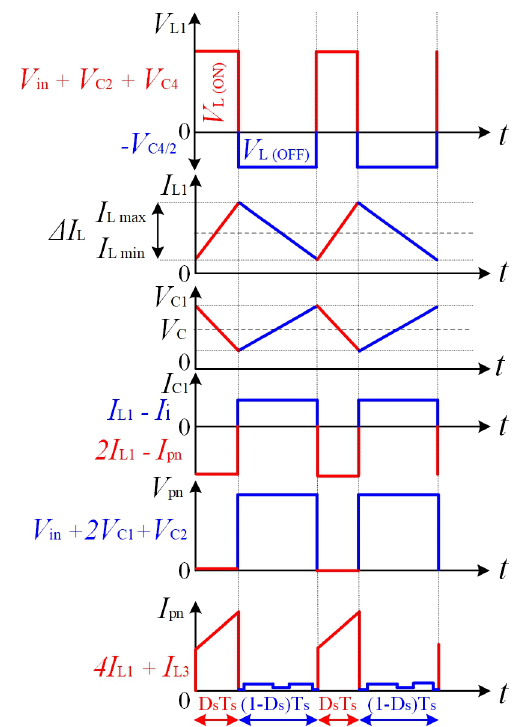
Figure 3. Key switching waveforms for the switched inductor assisted strong boost Z-source inverter